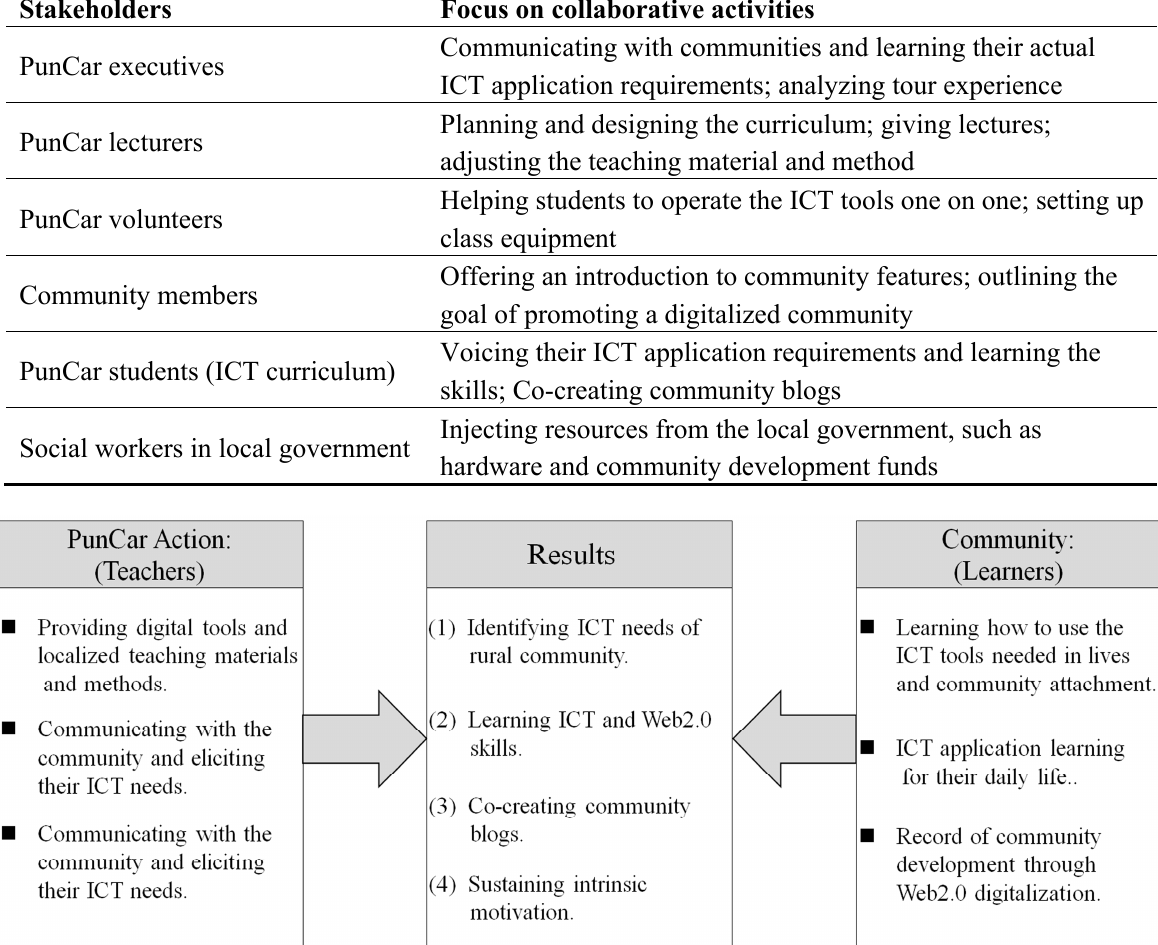
Table 3. PunCar Action partnerships and activities with stakeholders.